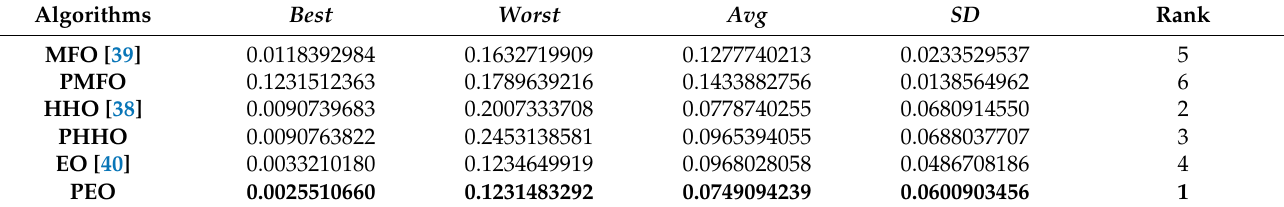
Table 10. Comparison of statistical measures of STM6.